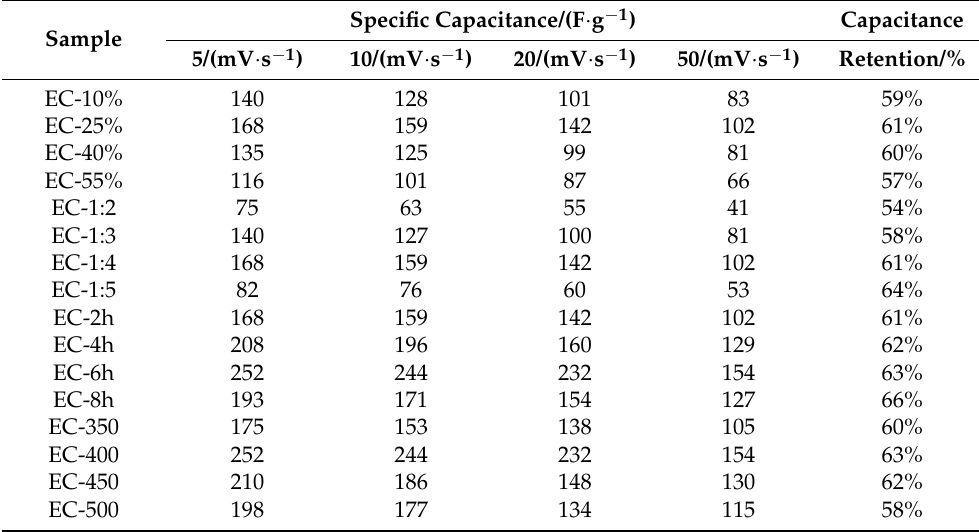
Table 3. The specific capacitance of ECs at 5 mV · s − 1